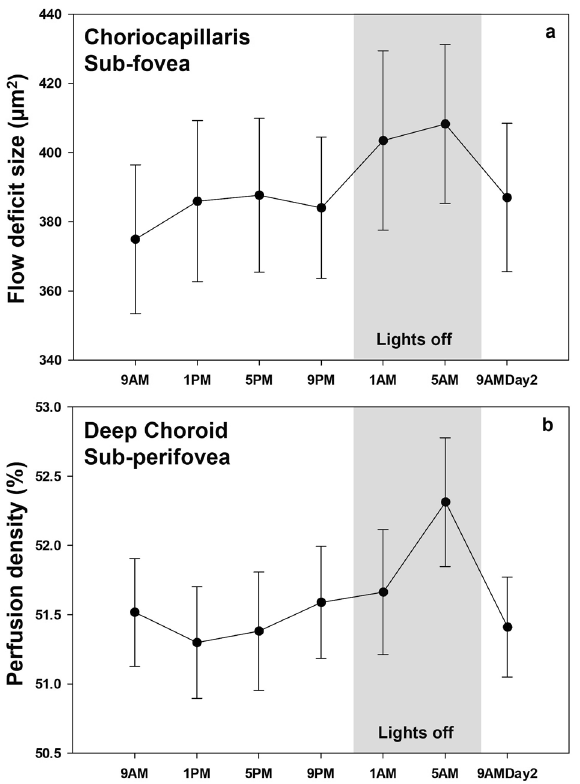
Figure 2. Choriocapillaris flow deficit indices ( a ) and deep choroid perfusion density ( b ) plotted across 24 h for all participants in the three regions. The peak for these indices were observed between 2 and 6 AM. For all time points, error bars indicate one standard error of the